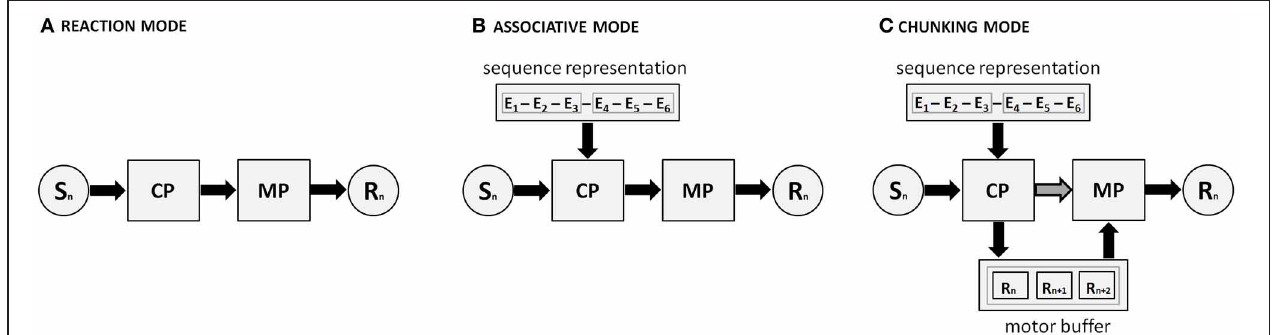
FIGURE 3 | The dual processormodel (DPM) involves a cognitive processor(CP) and a motorprocessor(MP) thattogetherdrive three distinct modes of sequence execution, throughlong-termsequential knowledge and the temporary storage in a motorbuffer (in the case of motorchunking). S n and R n denote the current stimulus and corresponding response within the sequence, respectively. Black arrows and boxes denote the relevant processing routes. (A) In the reaction mode, responses are selected by the cognitive processor (CP) on the basis of S-R translation. (B) Ongoing response selection by the CP is facilitated by the first, still weak, sequence knowledge that develops. (C) Motor chunks havedeveloped,